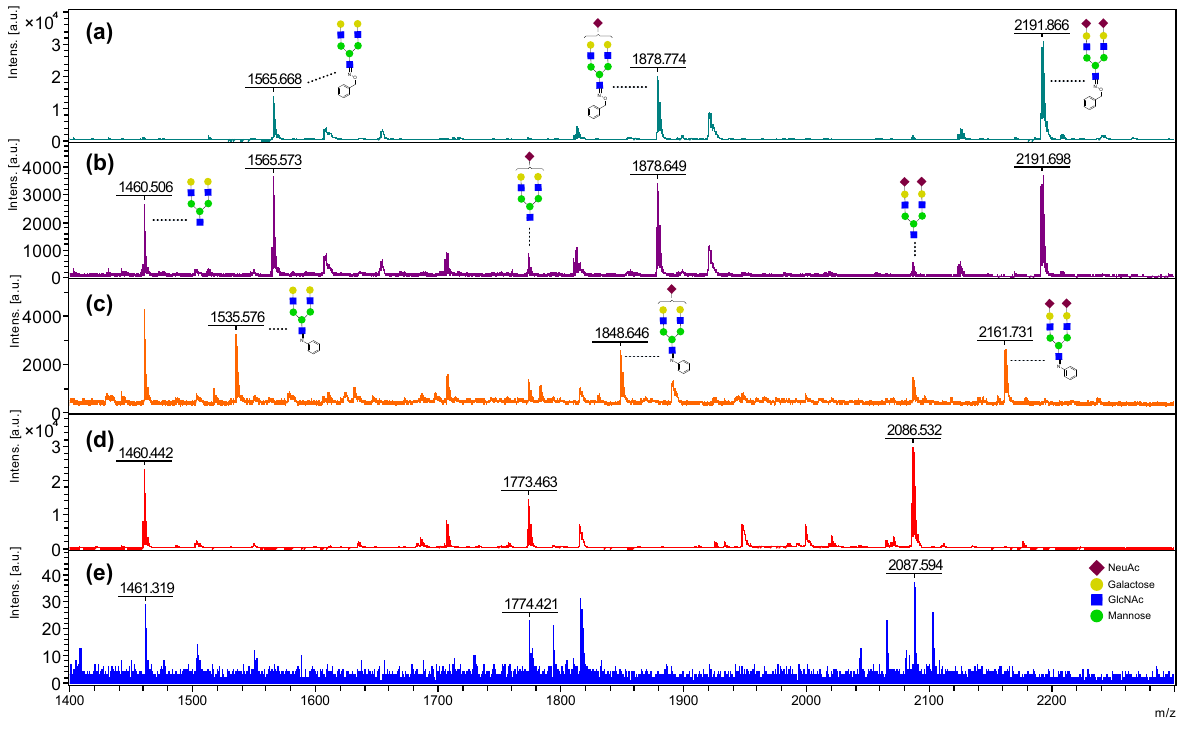
Figure 3. MALDI–TOFMS spectra of SGP-10 (5 pmol/spot) with each matrix system (laser power 40%, 500 shots, random walk mode) spotted on the AnchorChip TM MALDI target plate as shown in Figure 2: ( a ) BOA/DHB/Na, ( b ) BOA HCl/DHB/Na, ( c ) aniline/DHB/Na, ( d ) NMA/DHB/Na, and ( e ) DHB (0.1%